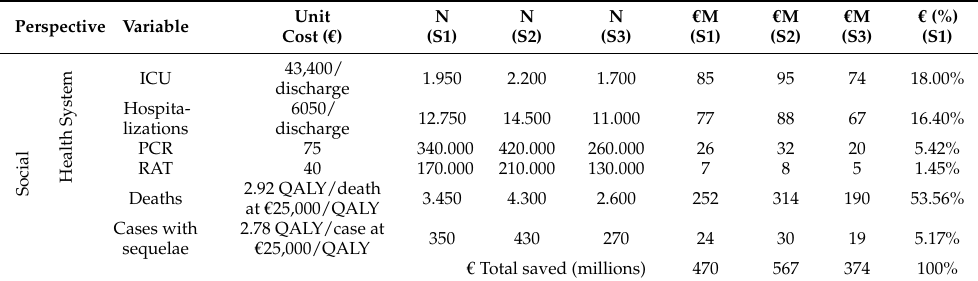
Table 2. Benefits of the vaccination campaign. Amounts avoided per scenario.